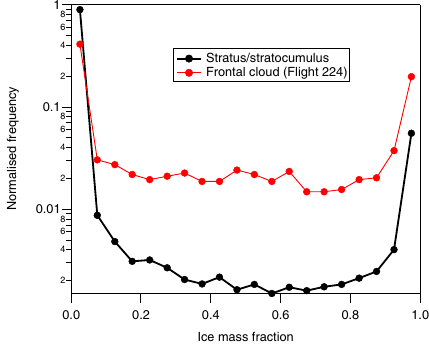
Figure 2. Frequency distribution of the 1Hz cloud ice mass fraction